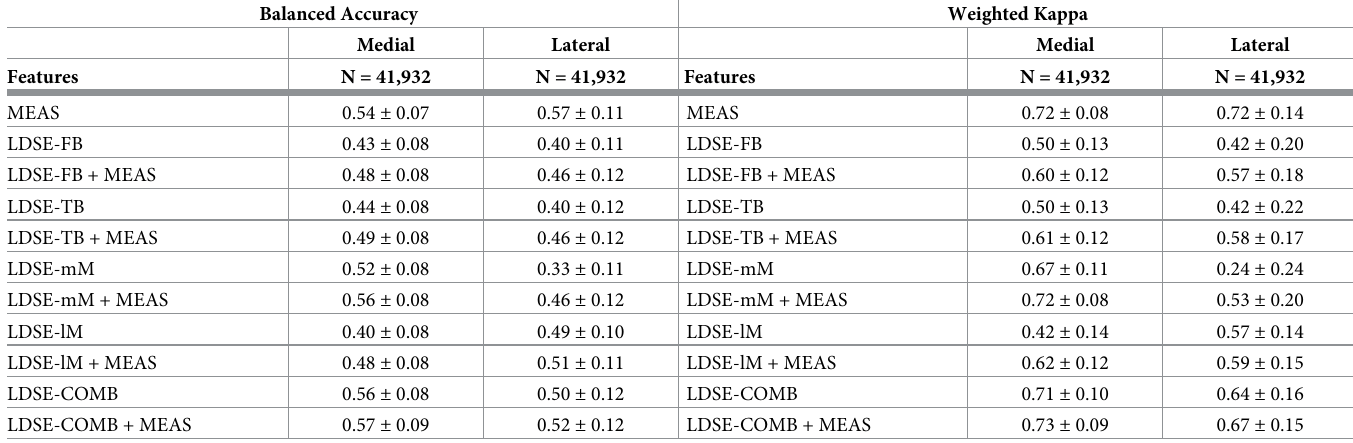
Table 4. Balanced accuracy and weighted kappa for classification of joint space narrowing (JSN) for medial and lateral femorotibial compartment averaged over all time points weighted by number of cases per time